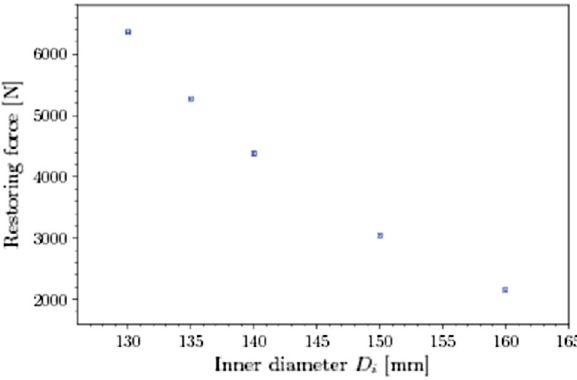
Fig. 6 Maximum coupling for different inner diameters of the drive